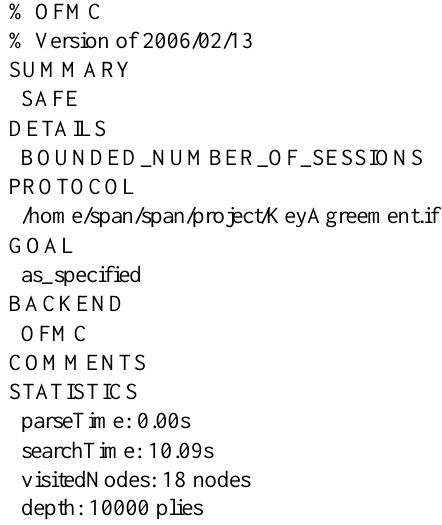
Figure 7. Security simulation verification results of the proposed